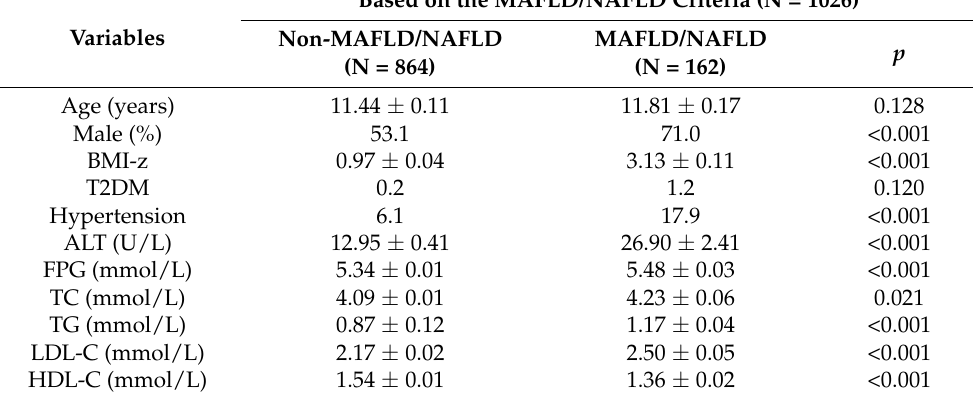
Table 3. Comparison of clinical parameters of participants diagnosed with MAFLD and NAFLD in CPOOA by ultrasound.